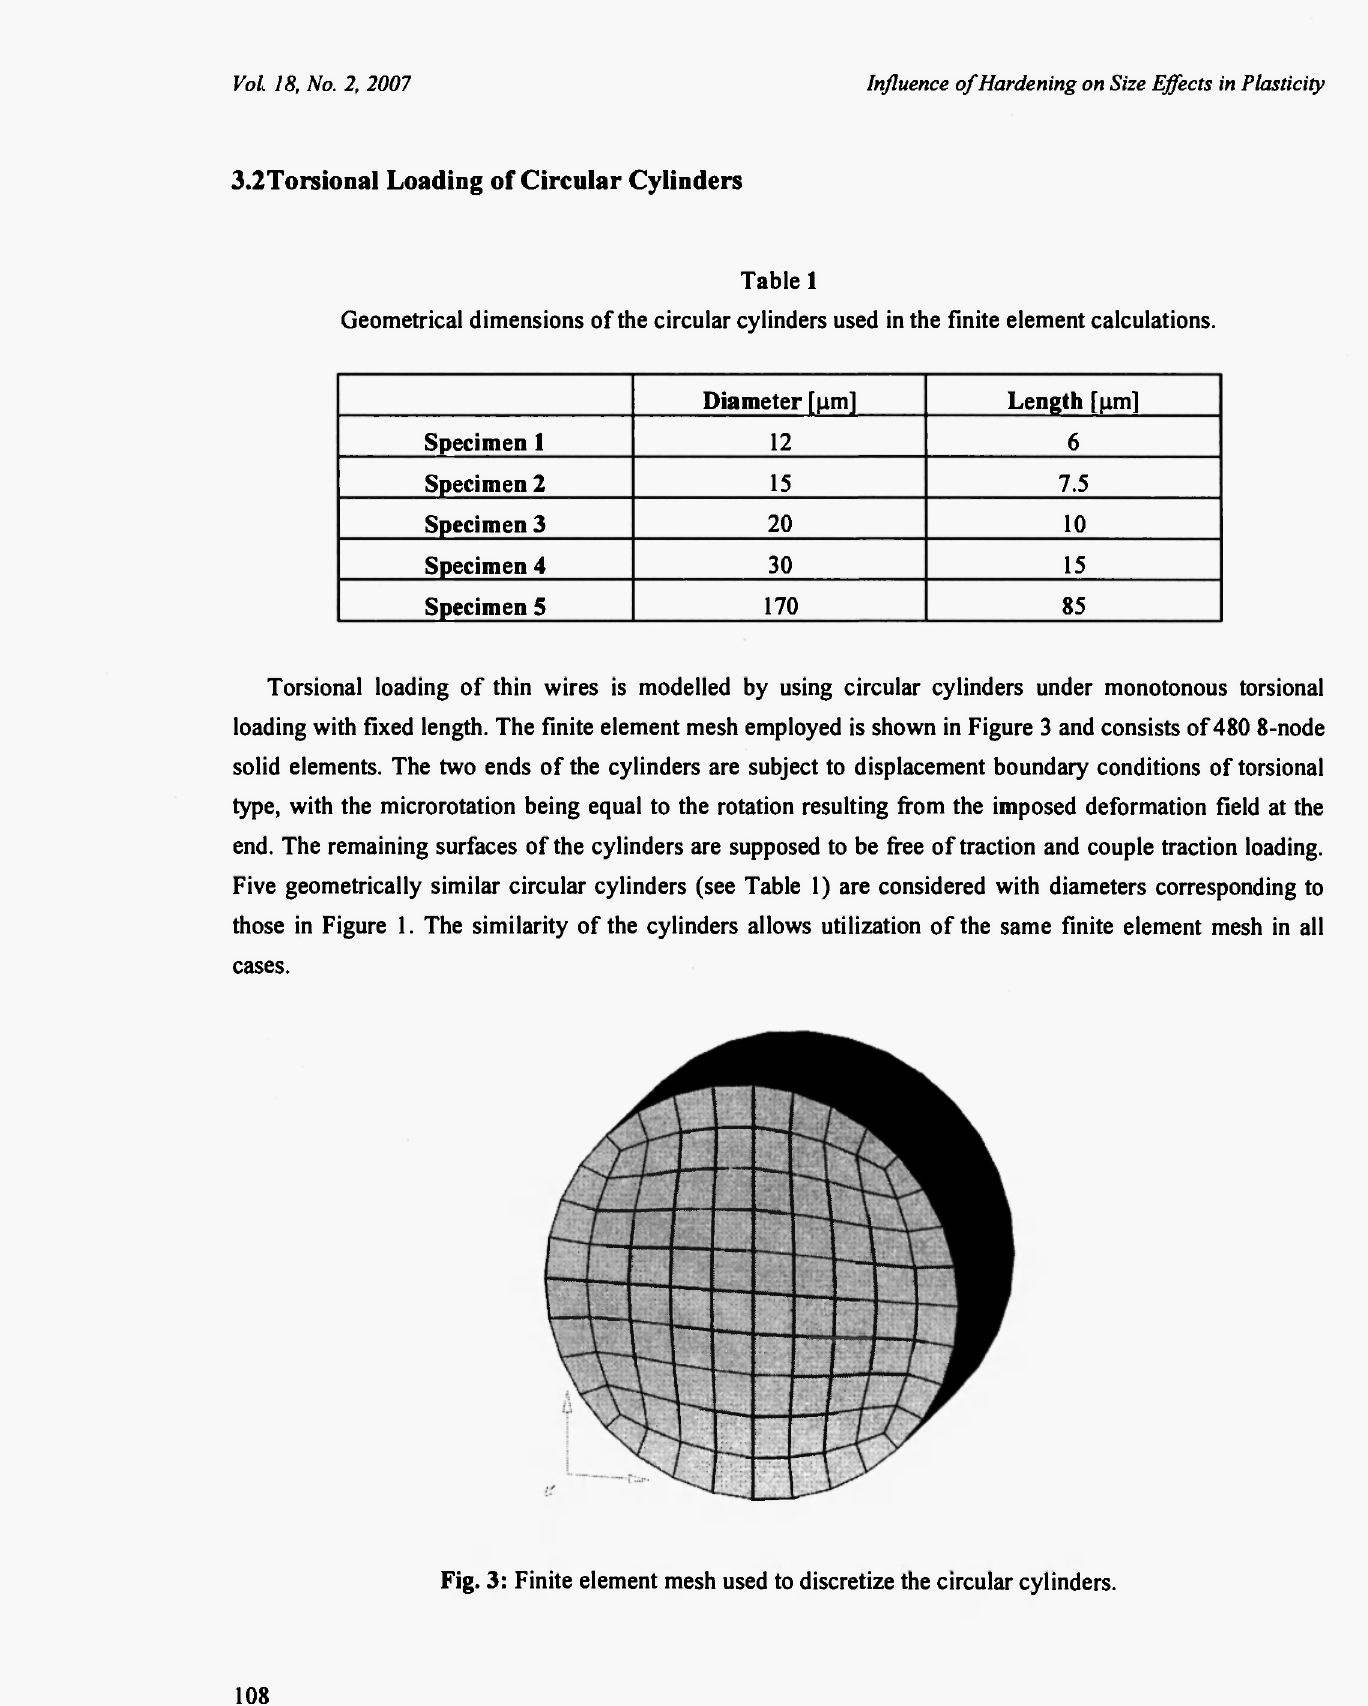
Fig. 3: Finite element mesh used to discretize the circular